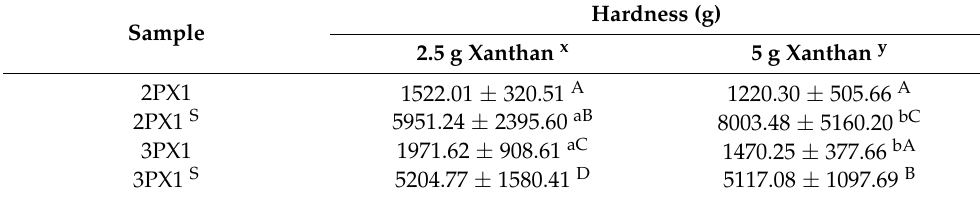
Table 3. Textural results of biodegradable spoons prepared with different amounts of xanthan.